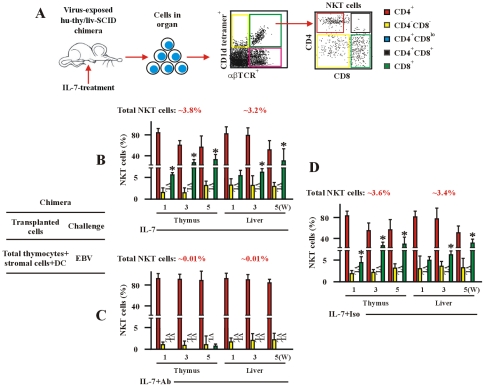
IL-7 is required for EBV-induced CD8+ NKT cell development in vivo.(A) The experimental and analysis scheme for detecting co-receptor-expressing NKT cells and T cells in various organs from hu-thy/liv-SCID chimeras treated with IL-7. The chimeras were established by intrathymic transplantation with DP thymocytes. The chimeras were treated i.v. with IL-7 (0.1 µg/kg/d), or with IL-7 plus mAb against IL-7 (1 µg/kg/d) (IL-7+Ab), or IL-7 plus isotype Ab (1 µg/kg/d) (IL-7+Iso) as indicated. The chimeras were sacrificed at the indicated time points following post-immune-reconstitution and viral challenge. Staining was performed as in Figure 2. (B–D) Development of co-receptor-expressing NKT cells. Data show the frequency of co-receptor-expressing NKT cells in thymus or livers from hu-thy/liv-SCID chimera challenged i.t. with EBV (EBV), as assessed by flow cytometry. The protocols for the establishment of the chimeras were described in the leftmost panel. +DC, thymic DCs were included. VL, very low level (below detectable level). Data (B–D) were mean ± s.d. (n = 7 or 8). *, p<0.001, EBV- and IL-7-challenged chimeras vs. a-IL-7 Ab-treated chimeras.